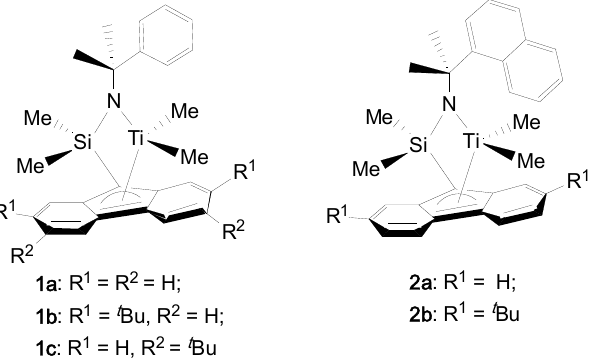
Figure 1. Chemical diagrams of the ansa -(fluorenyl)(amido) titanium complexes studied.